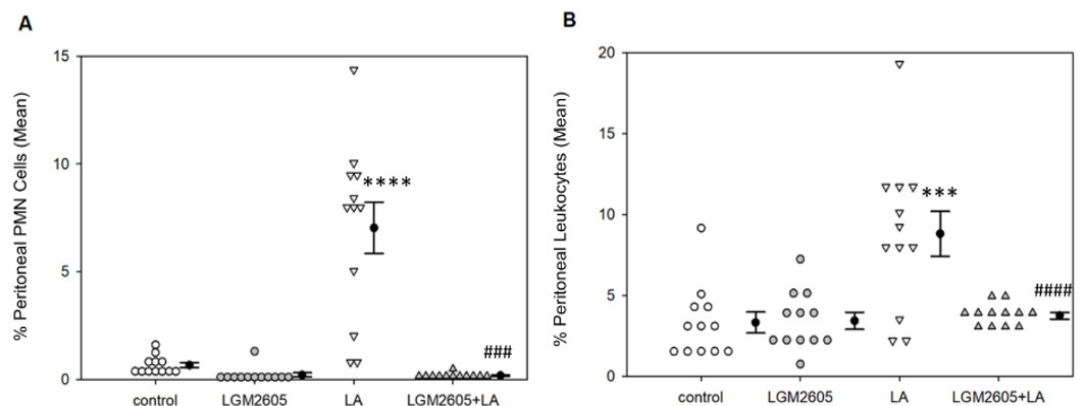
Figure 3. Detection of peritoneal PMN cells and leukocytes by flow cytometry. ( A ) LA treatment significantly increased the percentage of peritoneal PMNs compared to saline control, **** p < 0.0001; LGM2605 + LA treatment reduced the percentage of peritoneal PMNs back to control levels, ### p < 0.001. ( B ) LA treatment significantly increased the percentage of peritoneal compared to saline control, *** p < 0.001; LGM2605 + LA treatment reduced the percentage of peritoneal back to control levels, #### p < 0.0001. Following two-way ANOVA, data were analyzed via Tukey post-hoc test.